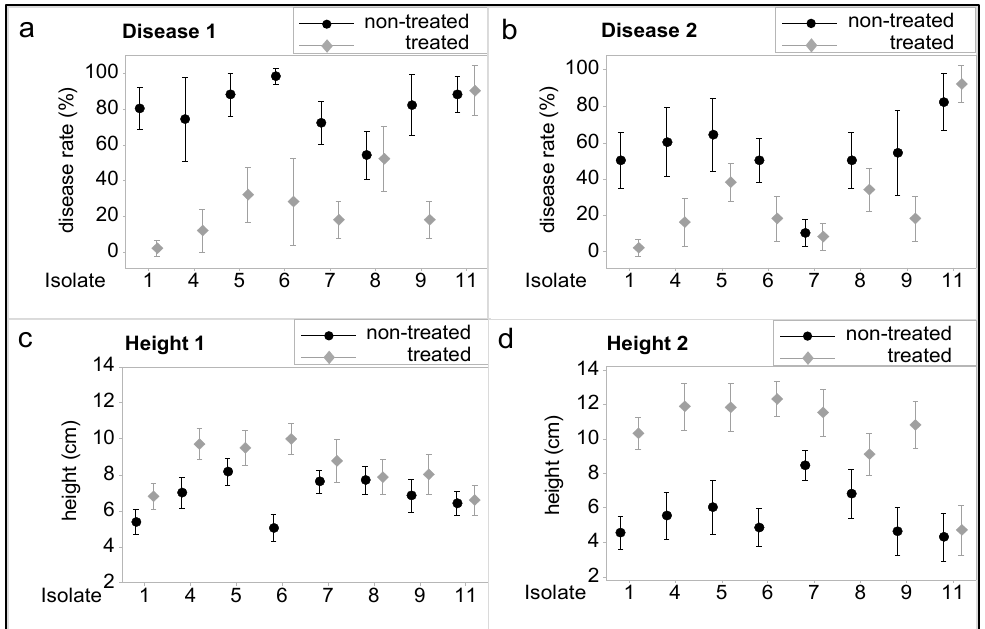
Figure 1. Disease rates ( a , b ) and heights ( c , d ) of mefenoxam-treated and non-treated sunflower plants inoculated with different Plasmopara halstedii isolates. Disease 1: ratio of sporulating pre-emergence damped-off plants and healthy sunflowers nine days after inoculation. Disease 2: ratio of chlorotic post-emergence damped-off plants and healthy sunflowers 21 days after inoculation. Height 1: height of sunflowers nine days after inoculation (heights of damped-off plants were taken as zero). Height 2: height of sunflowers 21 days after inoculation (heights of damped-off plants were taken as zero). Treatment: non-treated and treated with mefenoxam (3 mg/kg seed). Isolate: code of Plasmopara halstedii isolates used in the experiment (1, 4, 5, 6, 7, 8, 9, and 11) (for more details, see Table 1). Vertical lines represent 95% confidence intervals (95% CI) of the mean values of disease rates and heights.